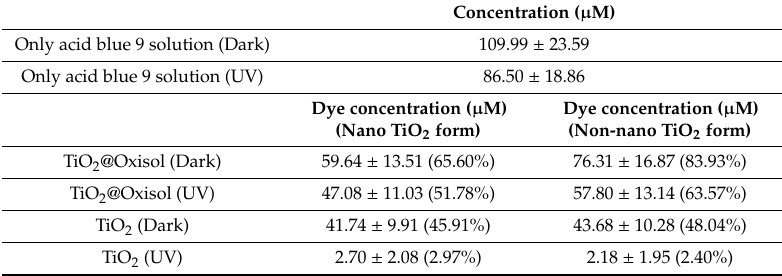
Table 8. Photocatalytic activity of untreated and functionalized TiO 2 . The values are reported as dye concentration: µ M and expressed as a percentage (value in brackets) after treatment.